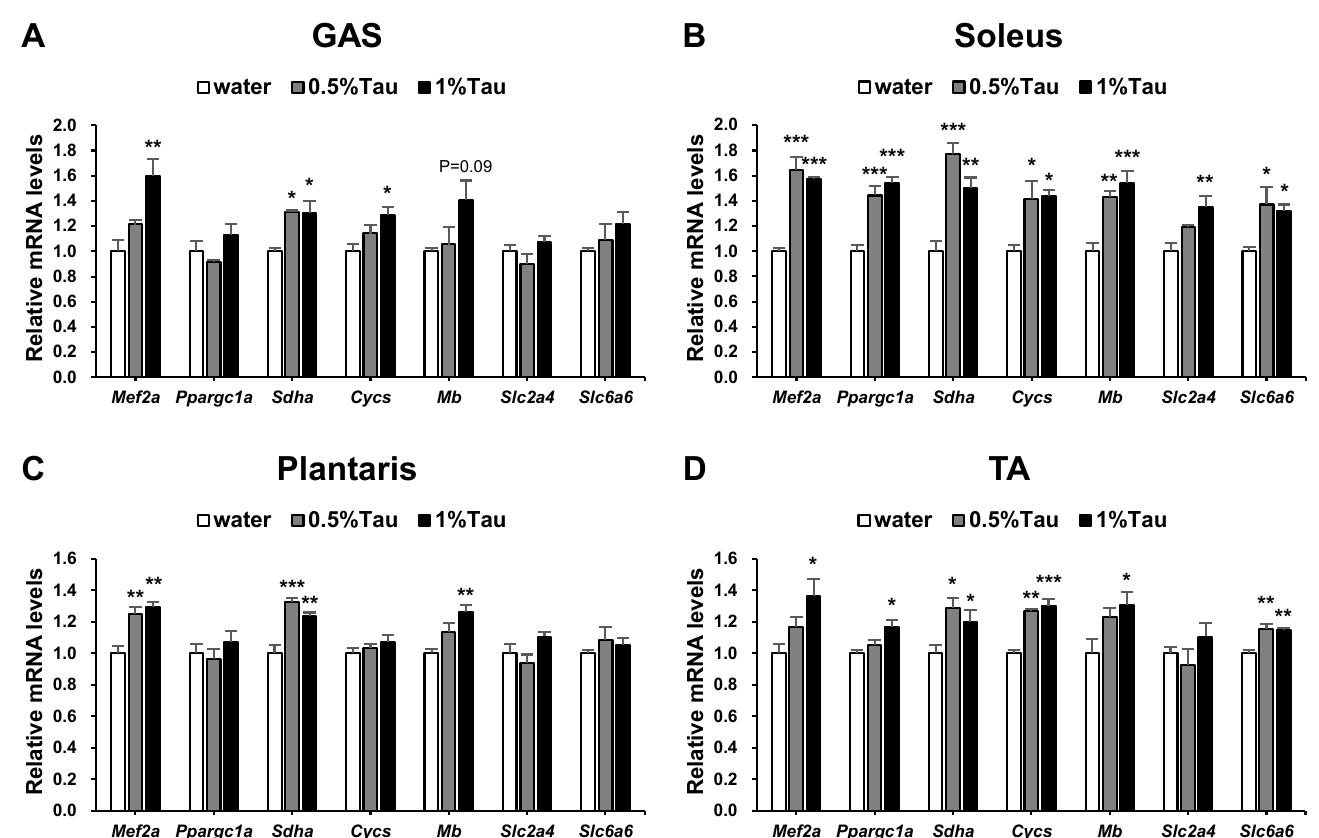
Figure 2. Effects of short-term taurine supplementation on the relative mRNA expression levels of skeletal muscle function-related genes in GAS ( A ), soleus ( B ), plantaris ( C ), and TA ( D ) muscles of rats in the water, 0.5% taurine, and 1% taurine groups. Skeletal muscles of SD rats at 14 weeks of age were collected 4 h after administration on the 10th day and analyzed via quantitative reverse transcription-polymerase chain reaction (qRT-PCR) to determine the mRNA expression levels of myocyte enhancer factor 2A ( Mef2a / MEF2A), peroxisome proliferator-activated receptor gamma coactivator 1-alpha ( Ppargc1a /PGC-1 α ), succinate dehydrogenase complex flavoprotein subunit A ( Sdha /SDH), cytochrome c, somatic ( Cycs /Cycs), myoglobin ( Mb ), solute carrier family 2 member 4 ( Slc2a4 /GLUT4), and solute carrier family 6 member 6 ( Slc6a6 /TauT). The administration levels of taurine are indicated in Figure 1. Values shown represent the mean ± SE (n = 3–6). * p < 0.05, ** p < 0.01, *** p <0.001, statistically significant versus the value of the water group. Results were analyzed using Dunnett’s test.